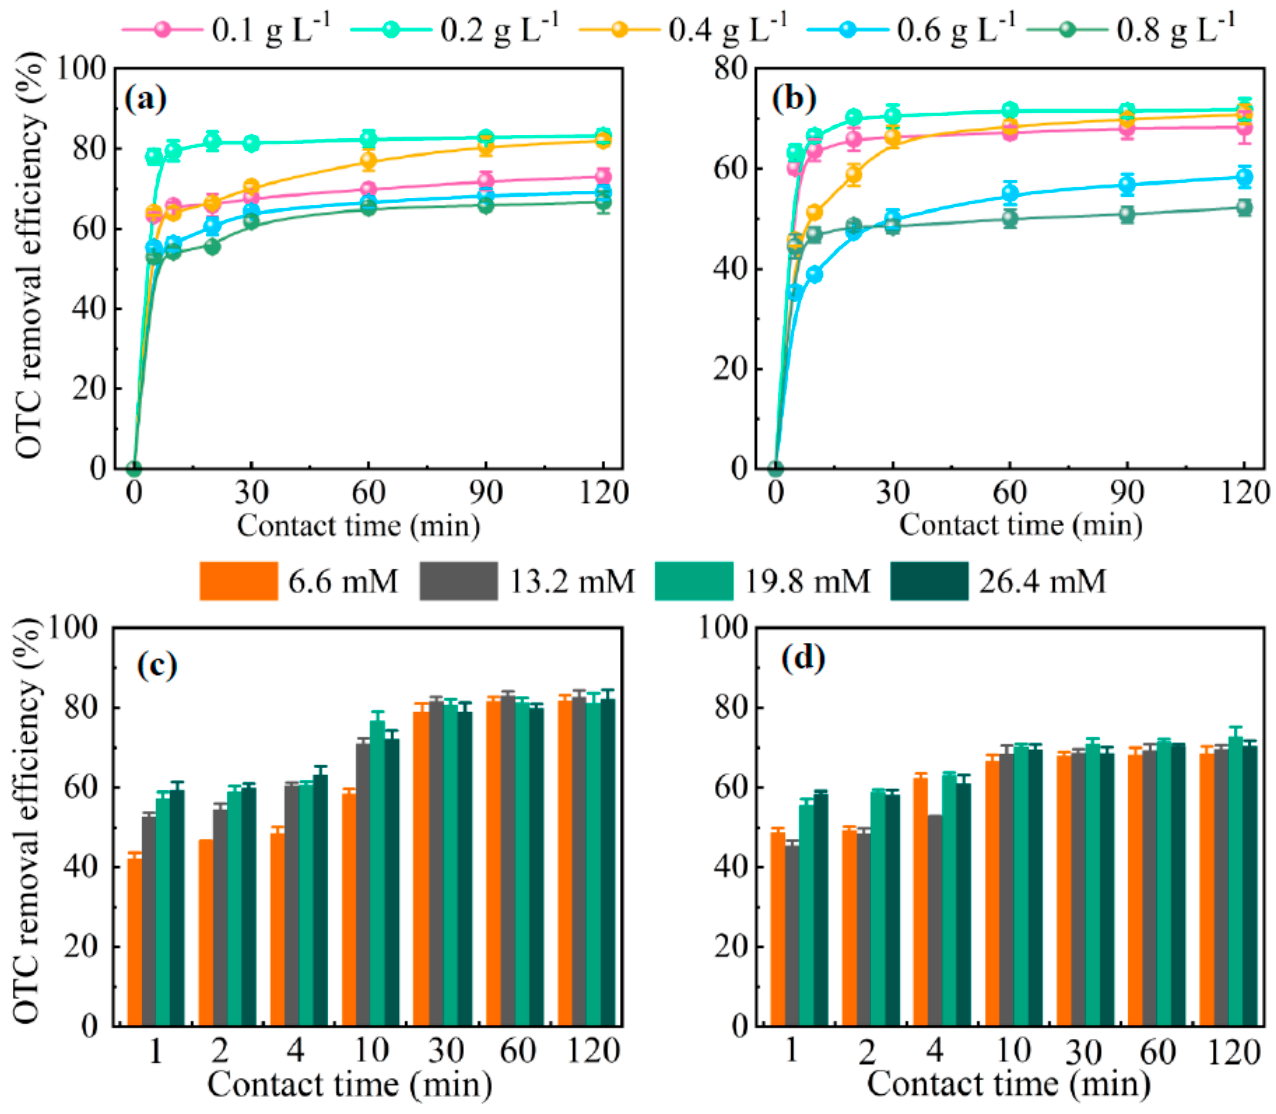
Figure 6. The effect of PMS concentration ( a , b ) and H 2 O 2 dosage ( c , d ) on OTC removal by RS–FeS ( a , c ) and RS–EDTA–FeS ( b , d ) (C 0 = 20.00 mg L –1 , initial pH in H 2 O 2 system = 3.00, initial pH in PMS system = 6.00).